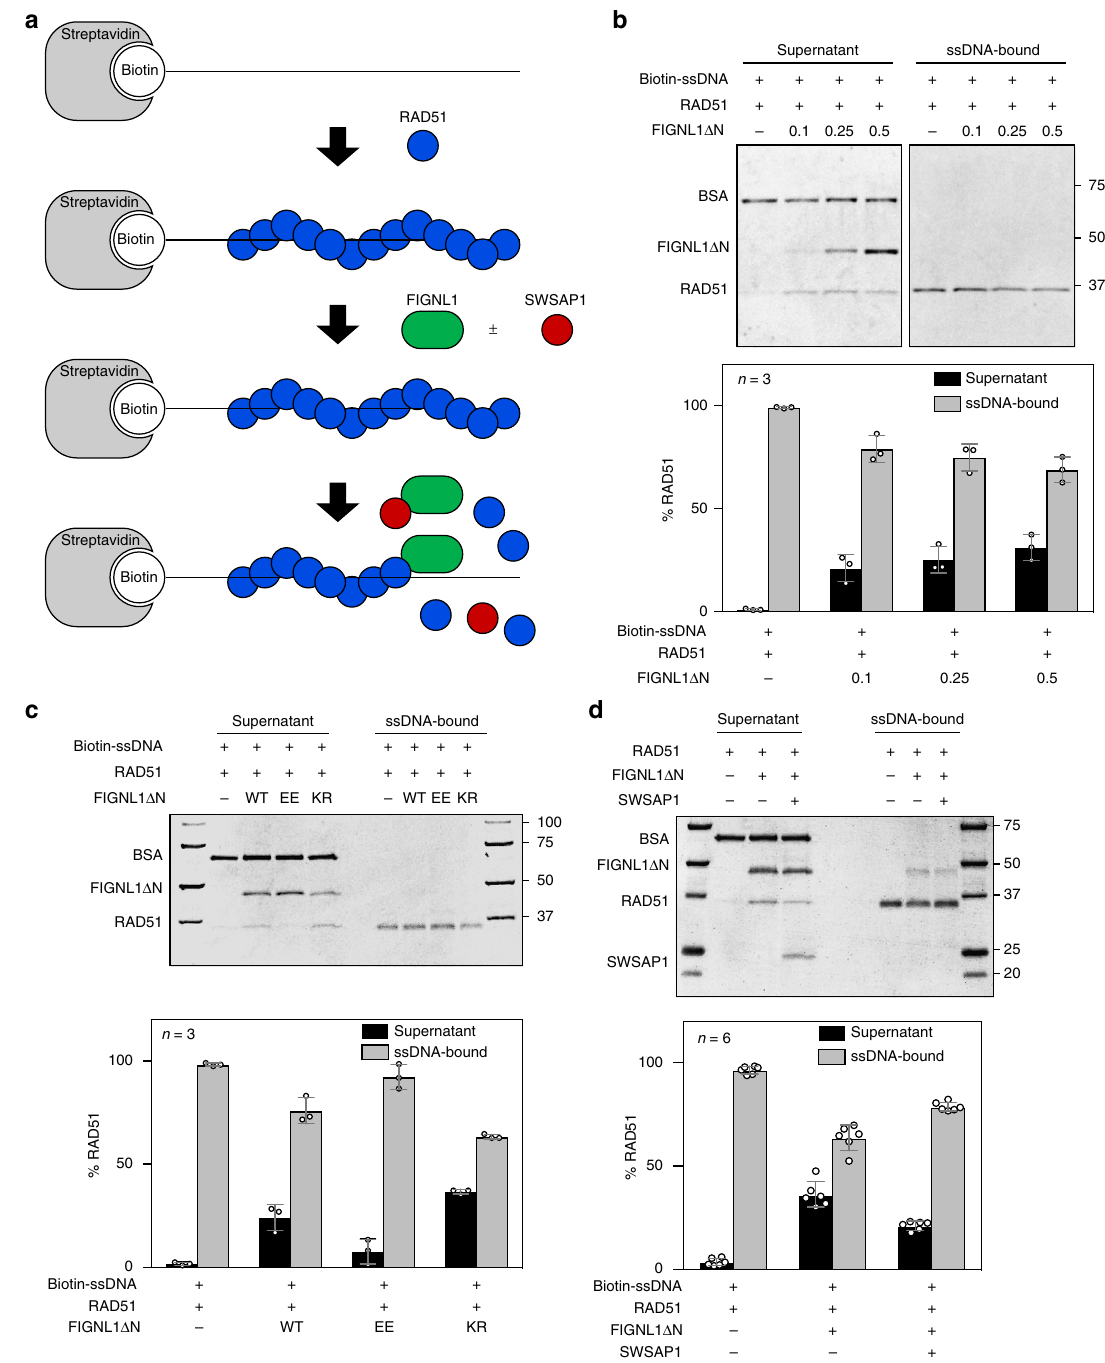
Fig. 4 FIGNL1 dismantles RAD51 from ssDNA. a Schematics of RAD51 disassembly assay from ssDNA immobilized on magnetic beads. b RAD51 disassembly assay in the presence of FIGNL1 Δ N. ssDNA-prebound to RAD51 was incubated with an increased concentrations of puri fi ed FIGNL1 Δ N. After 30 min, supernatants and bound fractions were recovered. Top, a representative SDS-PAGE gel for supernatants and bound fractions stained with CBB. Bottom, Quanti fi cation of dissociated RAD51 (Supernatant) and ssDNA-bound RAD51. Intensity of each band of RAD51 was quanti fi ed by Imager. The values of RAD51 bands in the supernatant or ssDNA-bound fractions were divided by the total value of RAD51 bands (both in supernatant and bound fractions). Data are mean ± s.d. n = 3. Statistical signi fi cance was measured by two-tailed Student ’ s t- test, see accompanying Source data. c RAD51 disassembly from ssDNA by FIGNL1 mutants. 0.2 μ M of FIGNL1 Δ N, FIGNL1 Δ N-EE (F295E, A298E) or FIGNL1 Δ N-KR (K447R) were added to ssDNA-pre- bound beads with RAD51. The binding of RAD51 was analyzed as described in a . Representative gel (top) and quanti fi cation ( b ) are shown. Data are mean ± s.d. n = 3. Statistical signi fi cance was measured by two-tailed student ’ s t- test, see accompanying Source Data. d RAD51 disassembly from ssDNA in the presence of FIGNL1 Δ N and or SWSAP1. 0.5 μ M of SWSAP1 and 0.5 μ M of FIGNL1 Δ N were pre-incubated for 30 min and added to the RAD51-bound ssDNA beads. The binding of RAD51 was analyzed as described in a . Representative gel (top) and quanti fi cation ( b ) are shown. Data are mean ± s.d., n = 6. Statistical signi fi cance was measured by two-tailed student ’ s t- test, see accompanying Source